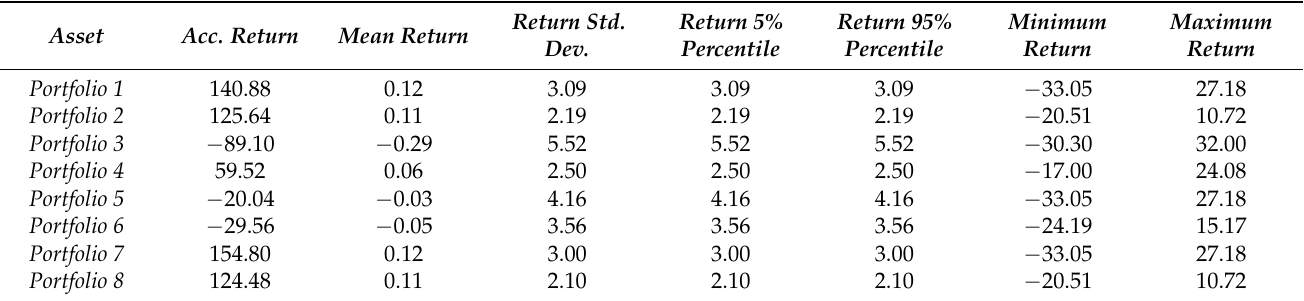
Table 5. Performance of the 8 simulated portfolios for a theoretical investor that pays no stock trading fees and future trading roll-over costs.